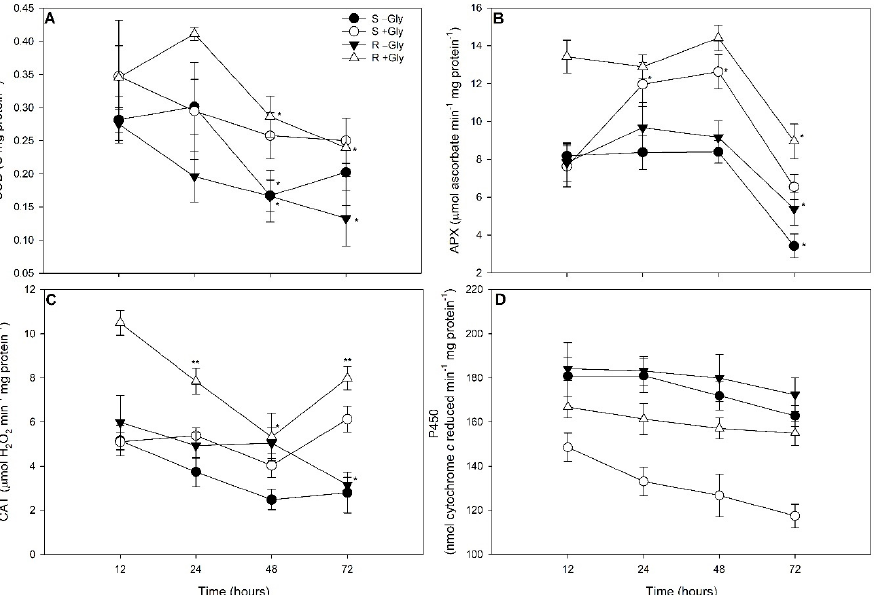
Figure 1. Activities of superoxide dismutase ( A ), ascorbate peroxidase ( B ), catalase ( C ), and NADPH-cytochrome P450 reductase ( D ) in glyphosate susceptible (S) and resistant (R) Conyza spp. plants exposed to 0 (-Gly) or 1080 g glyphosate (a.e.) ha − 1 (+Gly) for 72 h. Values are represented as the mean ± standard error of five replicates. * , ** indicates significant differences between times with the same biotype and glyphosate concentrations, by the Contrast test (considering p < 0.05).